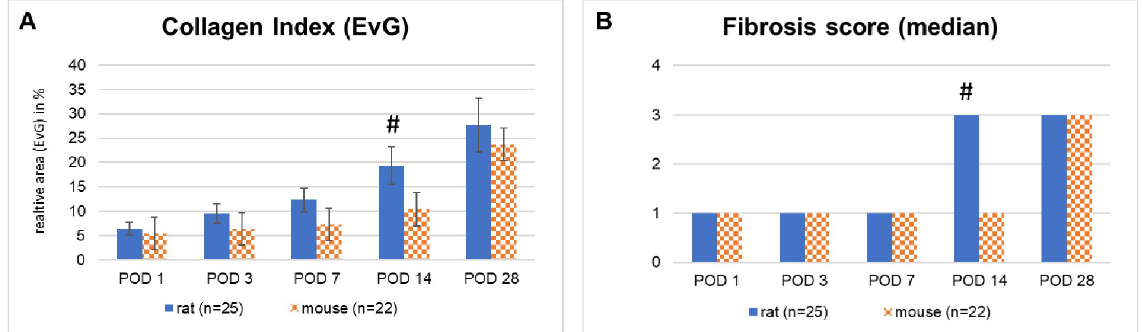
Fig 5. A, B: Relative area of collagen (Collagen Index) and zonal distribution of fibrous tissue (Fibrosis score) in rats and mice after tBDT (EvG staining).